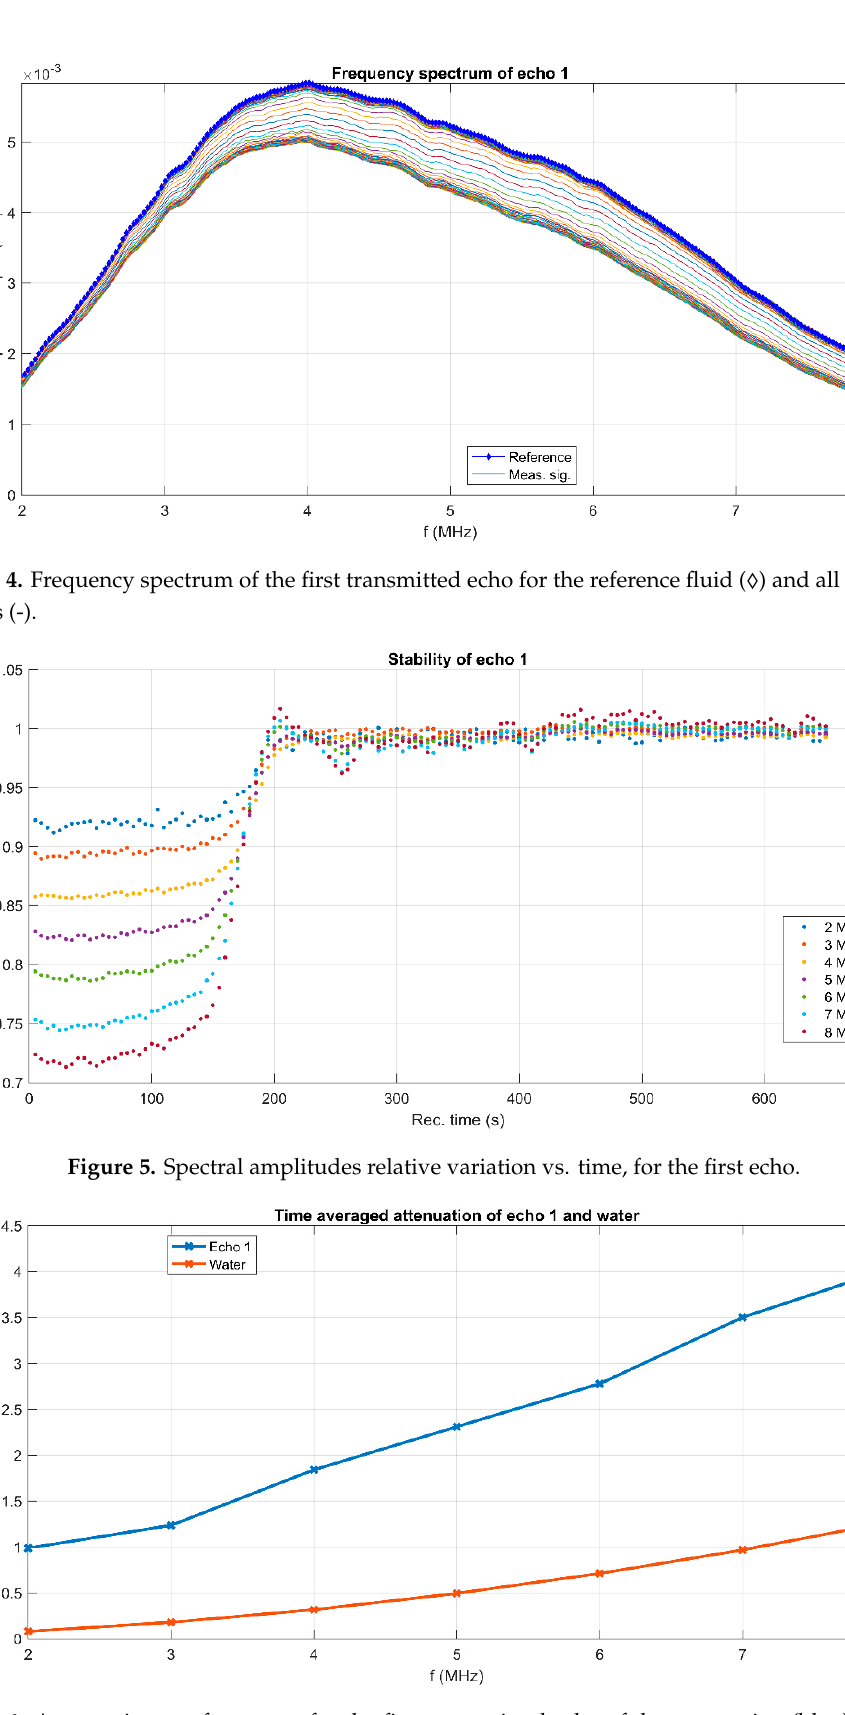
Figure 7. Attenuation vs. time for the spectral components of Echo 1. The hydrodynamic diameter (D H ) of the 10MgHAp nanoparticles were determined by DLS measurement of the particle size. The relationship between particle size and Brownian motion is described by the Stokes–Einstein Equation: 𝐷 (cid:3009) = kT 3  C, where, D H = hydrodynamic diameter, k = Boltzmann constant, T = absolute temperature, η = dynamic viscosity of the solvent, and C = diffusion constant. The average particle size and particle size distribution of the 10MgHAp sample analyzed by DLS method are presented in Figure 8a. The hydrodynamic diameter obtained was 158.3 ± 18 nm. A representative SEM image of the 10MgHAp material is presented in Figure 8c. The 10MgHAp particles have an approximately round shape and tend to aggregate into larger clusters. In order to determine the size distribution of 10MgHAp nanoparticles, the diameters of approximately 500 nanoparticles was measured (Figure 8c). The histogram reflecting the resulting values was fitted with a Gaussian function (Figure 8b). The average particle size calculated from SEM (D SEM ) image was of